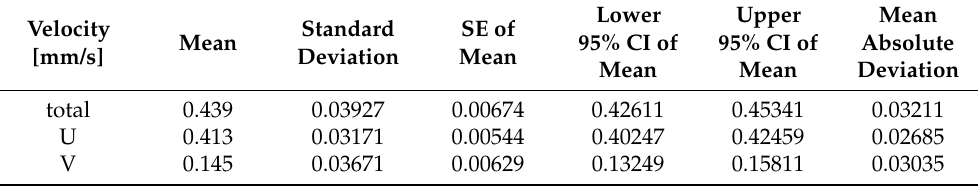
Table 2. The value of measurement uncertainty of PIV measured quantity.